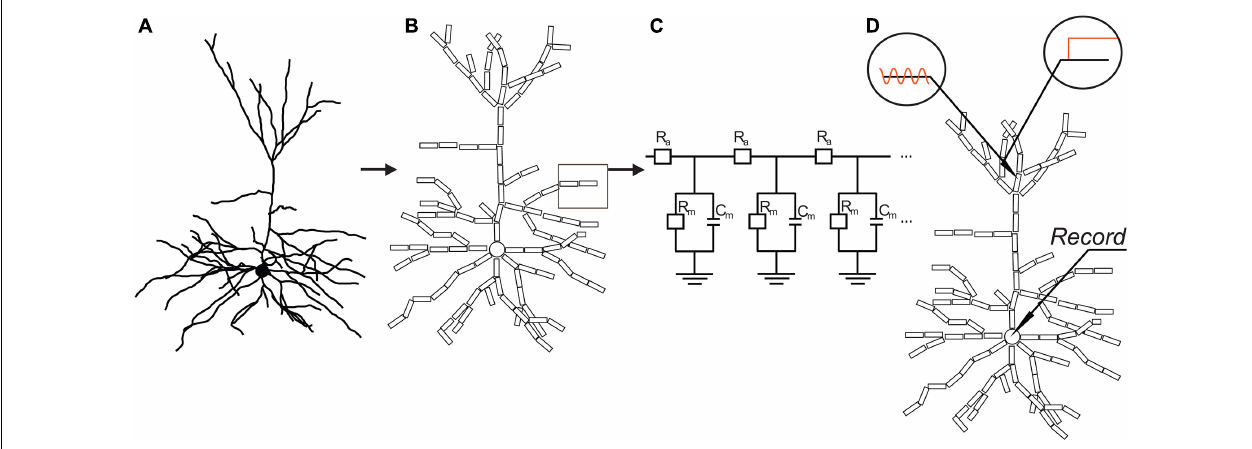
FIGURE 2 | Basic concept of compartmental models used in the study. Based on 3D reconstructed morphology of neurons (A) , dendrites were divided into cylindrical compartments, while the soma was represented by a single spherical compartment (B) . Compartments were replaced and coupled together by electrical equivalent circuits (C) with resistors and capacitors representing specific membrane resistance ( R m ) and capacitance ( C m ), as well as axial resistance of the dendroplasm ( R a ). PSPs were simulated by injecting constant or 50-Hz sinusoid current or by conductance changes at various locations of the modeled dendrites (D) . Transfers, delays of simulated PSPs to the soma, and rise times/half-widths of somatic EPSPs were measured by simultaneous recordings from dendritic